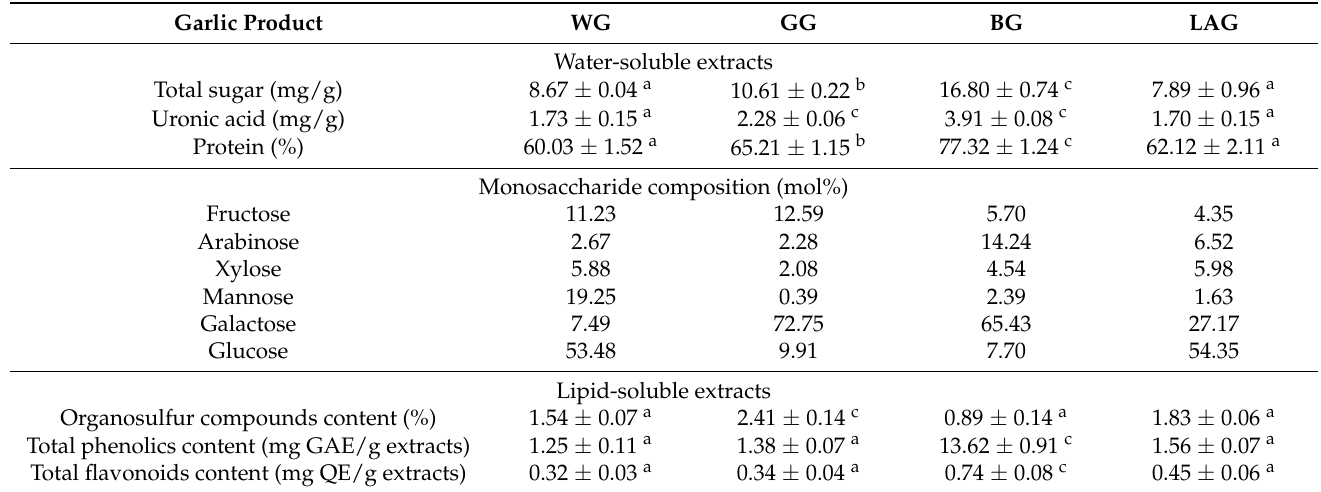
Table 1. The chemical constituents contents of water-soluble extracts and lipid-soluble extracts of WG, GG, BG and